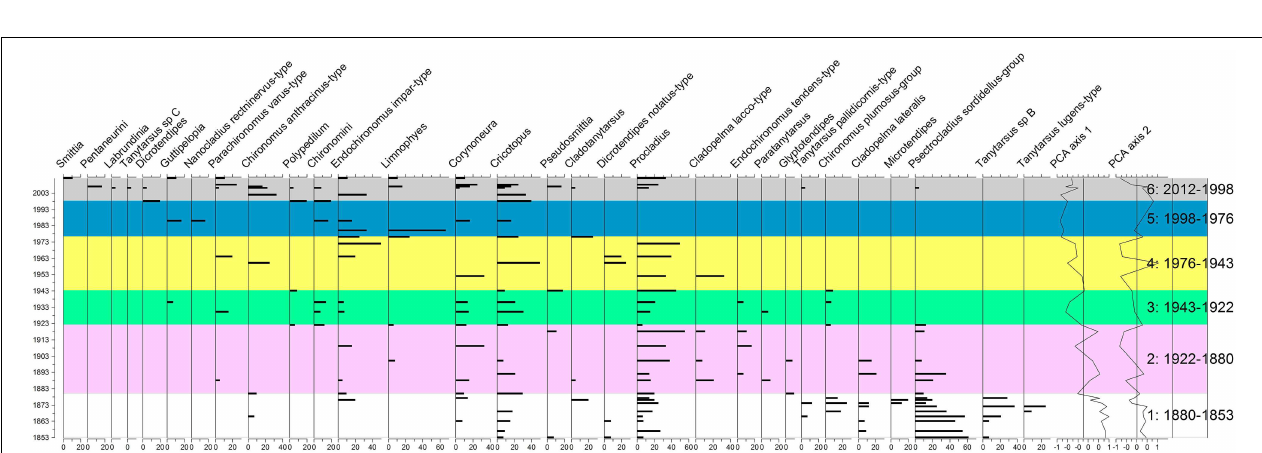
FIGURE 5 | Chironomid diagram. The taxa are in percentages. The zones were created using the technique of optimal splitting by information content (Birks and Gordon, 1985) and the number of statistically significant zones was identified using the Psimpoll 4.27 software (Bennett, 2009).